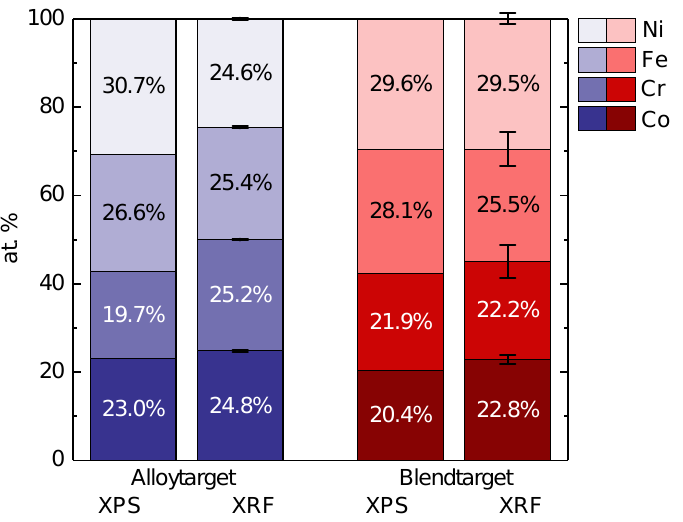
Figure 2. Stoichiometric composition of the Alloytarget and Blendtarget derived from X-ray photo- electron spectroscopy (XPS) and X-ray fluorescence (XRF). The error bars for the latter represent the standard deviation of different measurement